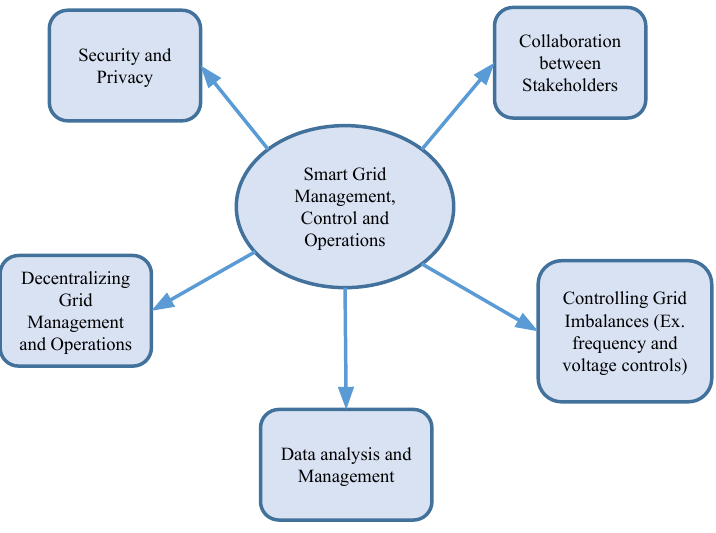
Figure 2. Challenges for management, control, and operation of smart